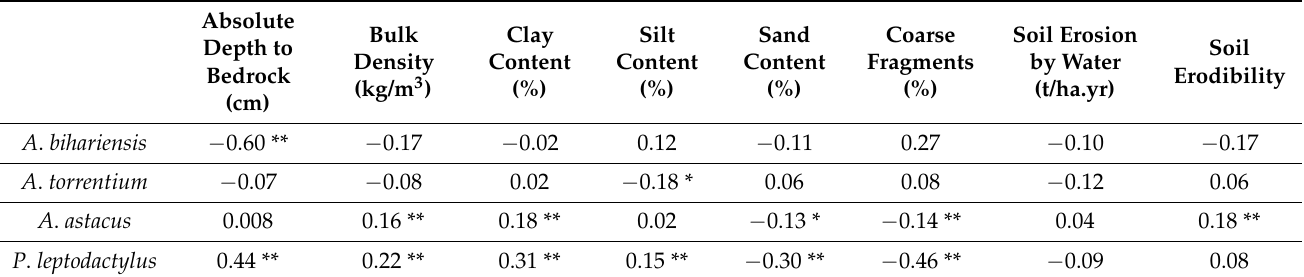
Table 2. Correlation coefficient between CPUE and soil-related predictors (** significant at the 0.01; * significant at the 0.05 level).